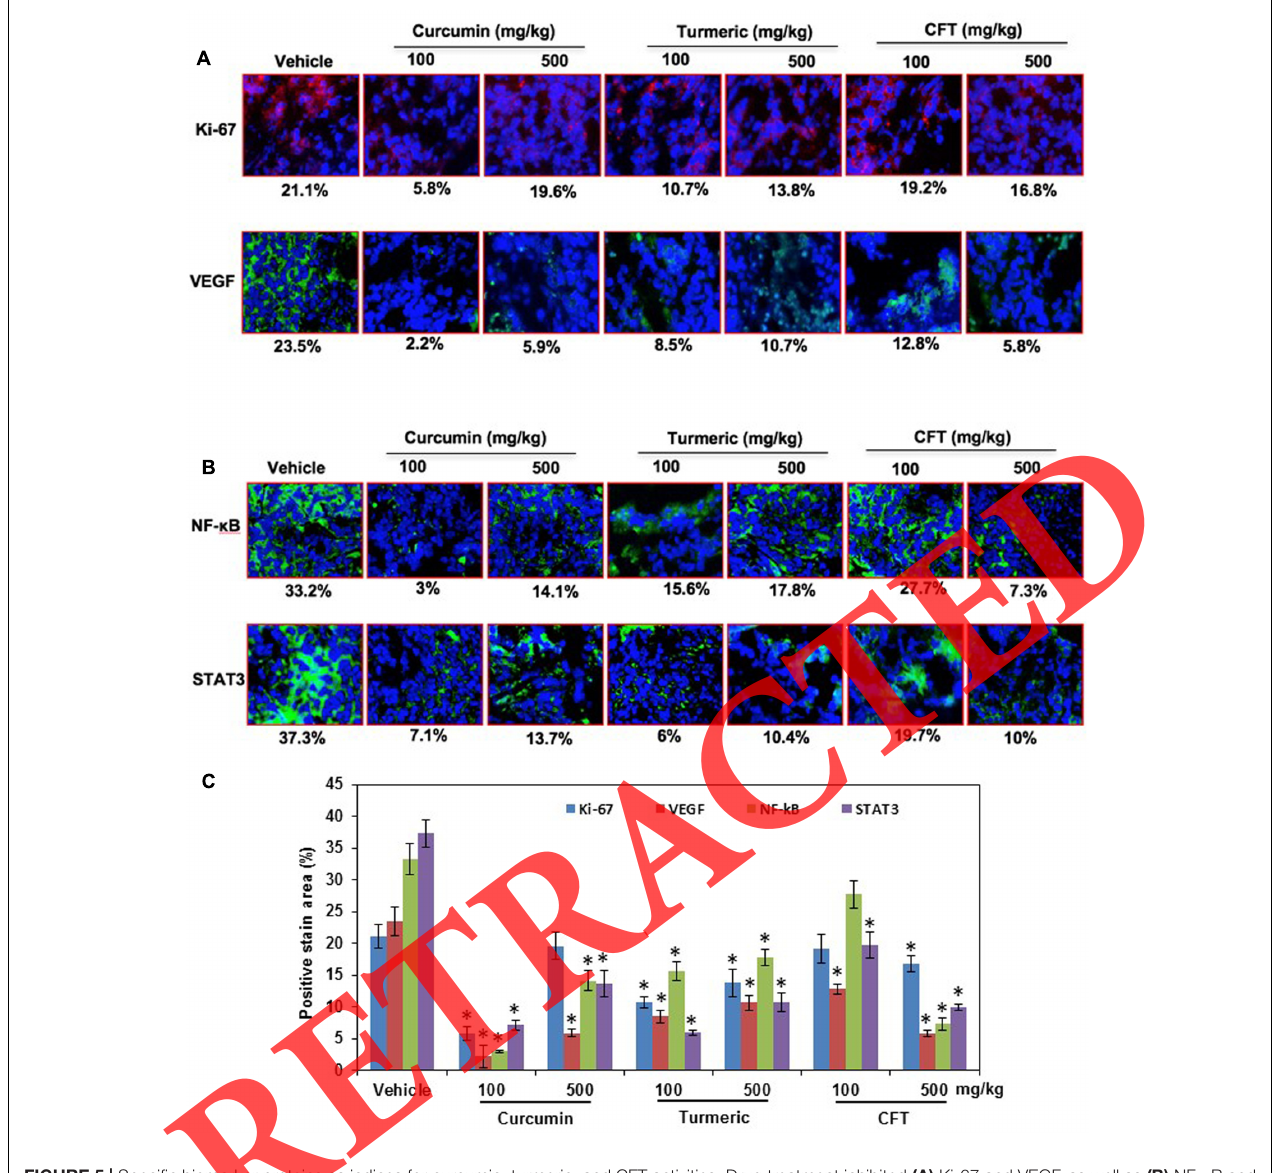
FIGURE 5 | Specific biomarker proteins as indices for curcumin, turmeric, and CFT activities. Drug treatment inhibited (A) Ki-67 and VEGF, as well as (B) NF- κ B and STAT3 in xenograft tumors from mice, and (C) the inhibited expressions were quantified for statistical significance ( ∗ P < 0.05 vs. vehicle control; N = 3). Tissue sections from the tumors were subjected to immunofluorescence analysis. Images were captured with a Photometrics Scientific CoolSNAP CF color camera (Photometrics, Tucson, AZ, United States) and analyzed to determine the percent of positive-staining cells with NIH ImageJ